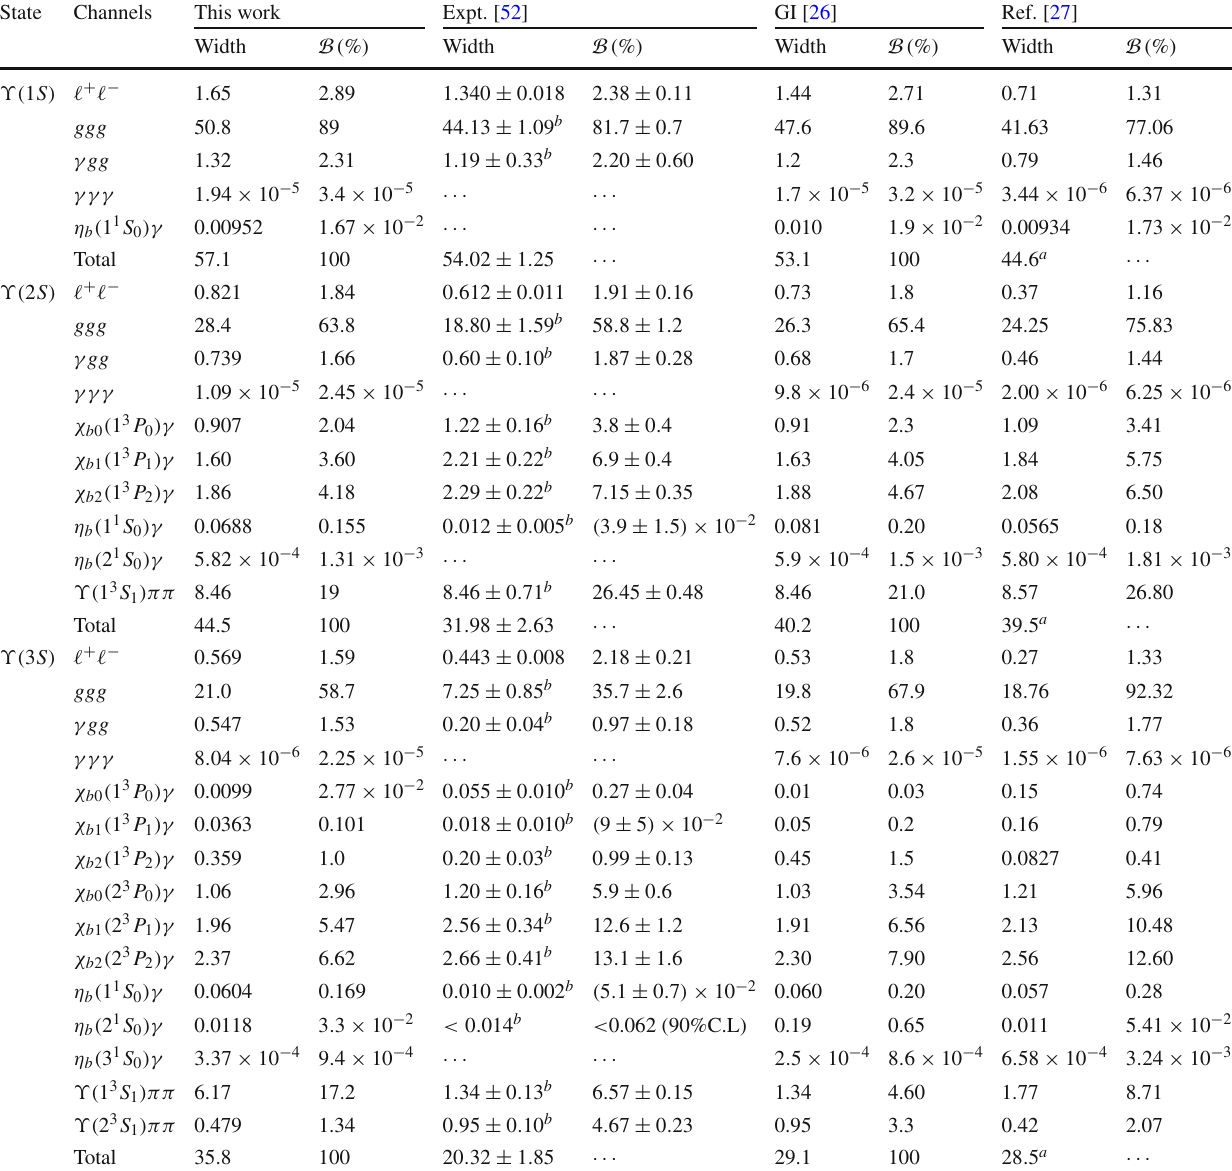
taken from the PDG [52]. The theoretical results of the GI model [26] and the nonrelativistic constituent quark model [27] are summarized in the rightmost columns. The width results are in units of